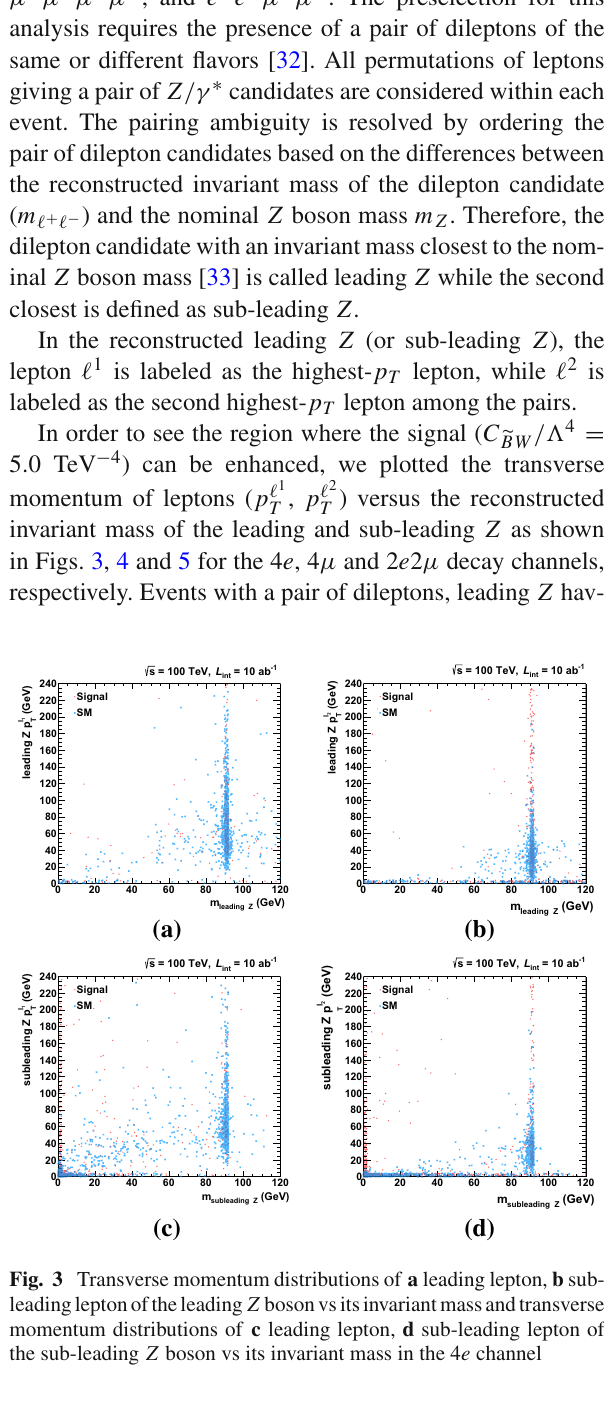
Fig. 1 The leading order Feynman diagrams of ZZ production a for signal including an aNTGC vertex depicted by a red dot, b for the SM background